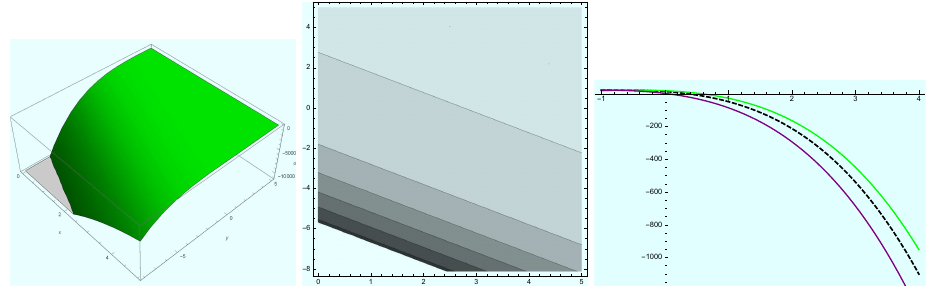
Figure 18. Evolution of traveling wave of series solution (34) at t = 5 and z =